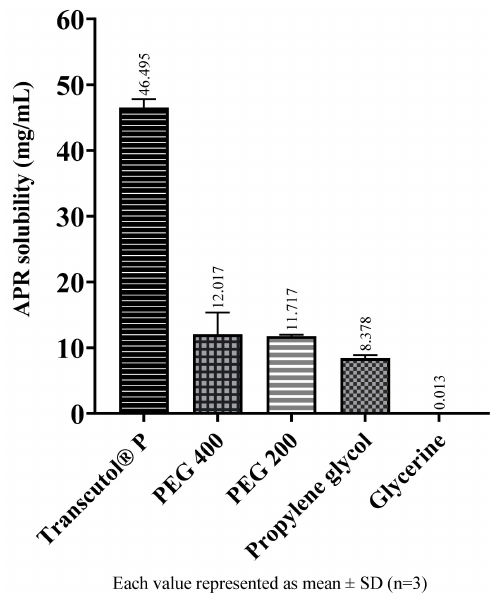
Figure 3. The solubility of APR at 25 ◦ C in cosolvents.